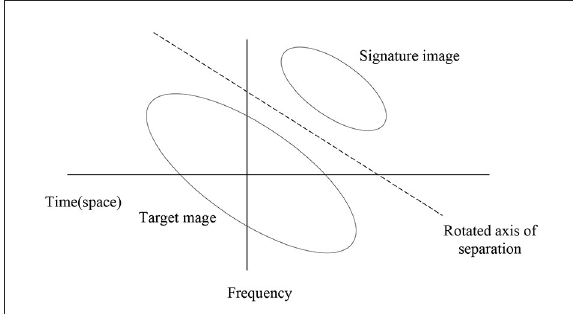
FIGURE8 Schematic representation of watermark extraction.